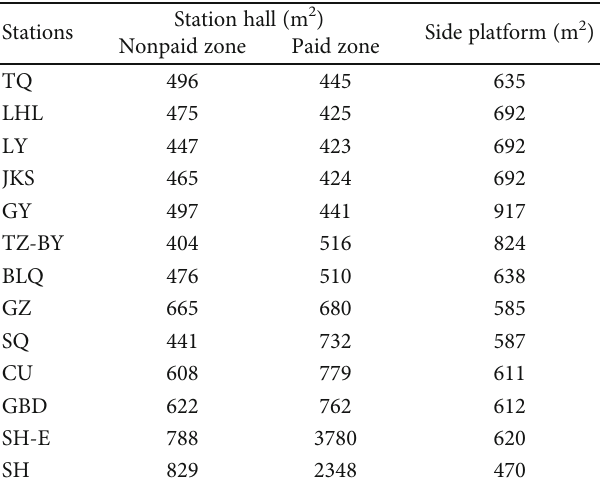
Table 2: The net acreage of each area of all stations on the Batong line.